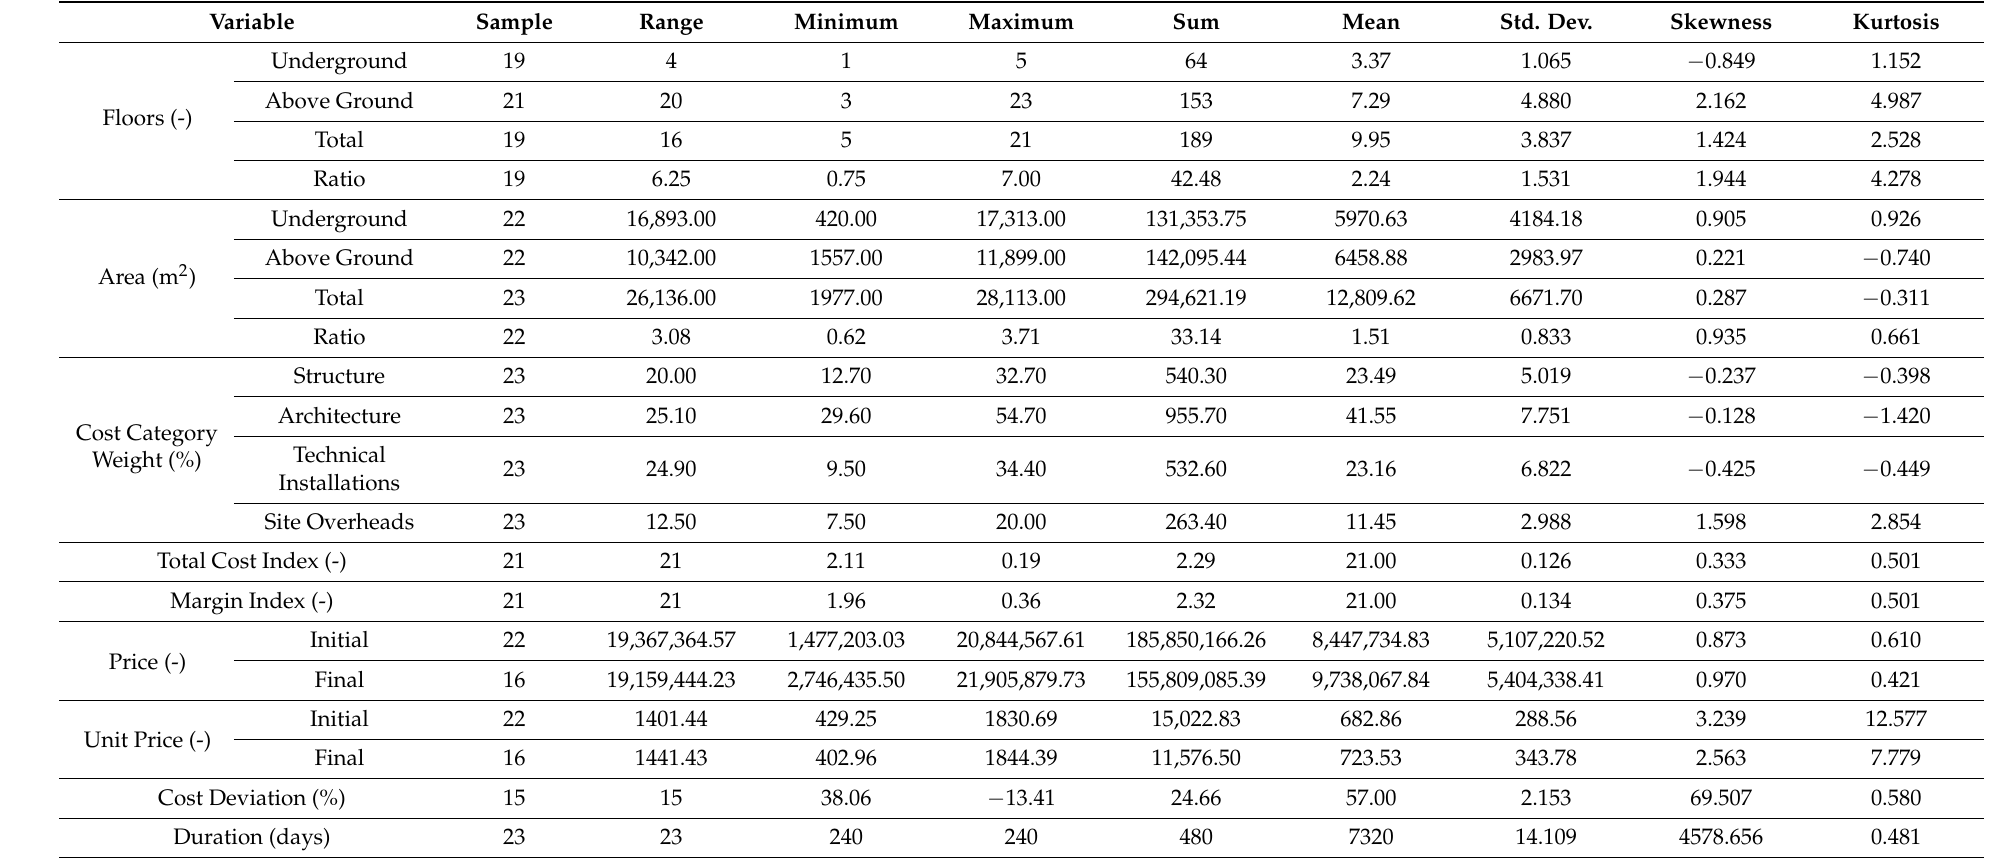
Table 2. Descriptive statistics of some of the main variables in the